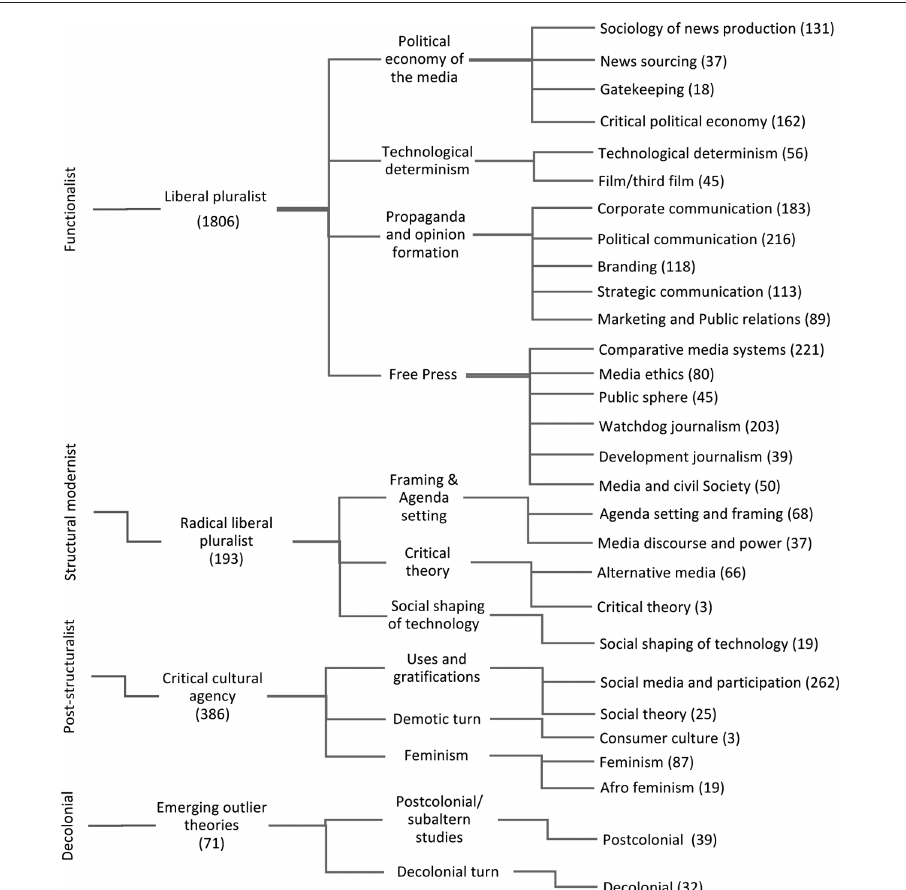
Figure 1: Relative dominance of the Western liberal pluralist theoretical grounding of works cited in sample reference lists – numbers indicate number of instances in the reference lists (Source: Author,